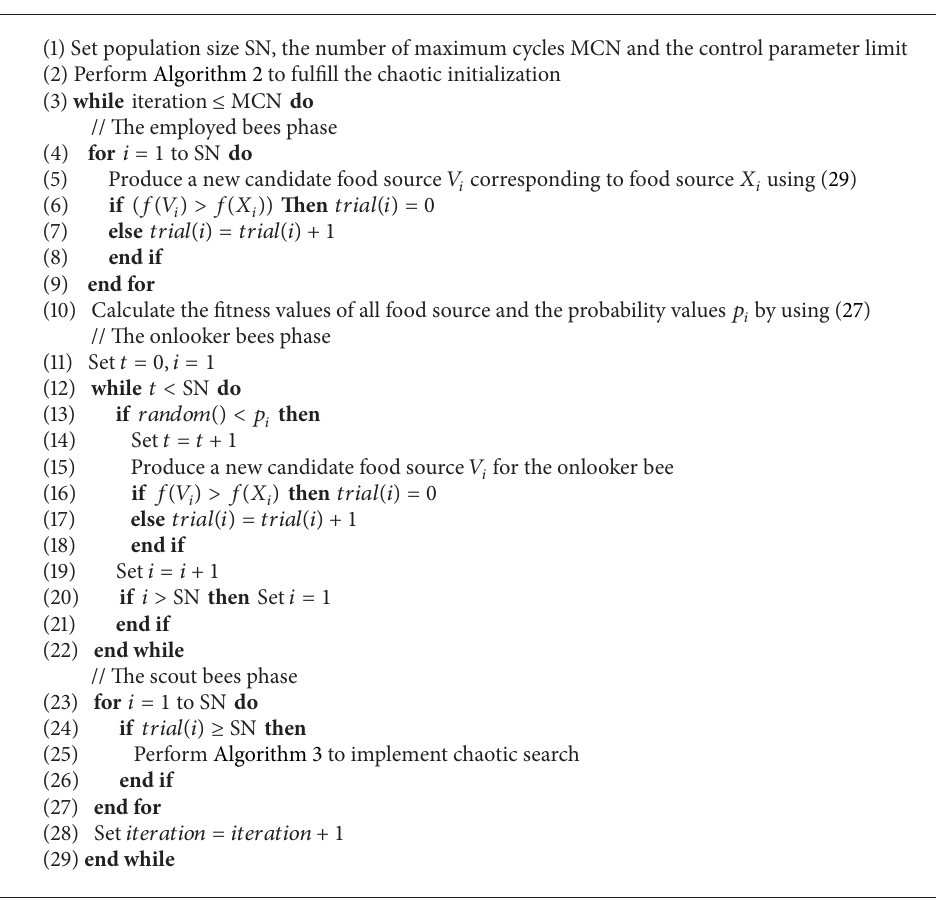
Algorithm 4: Modified ABC